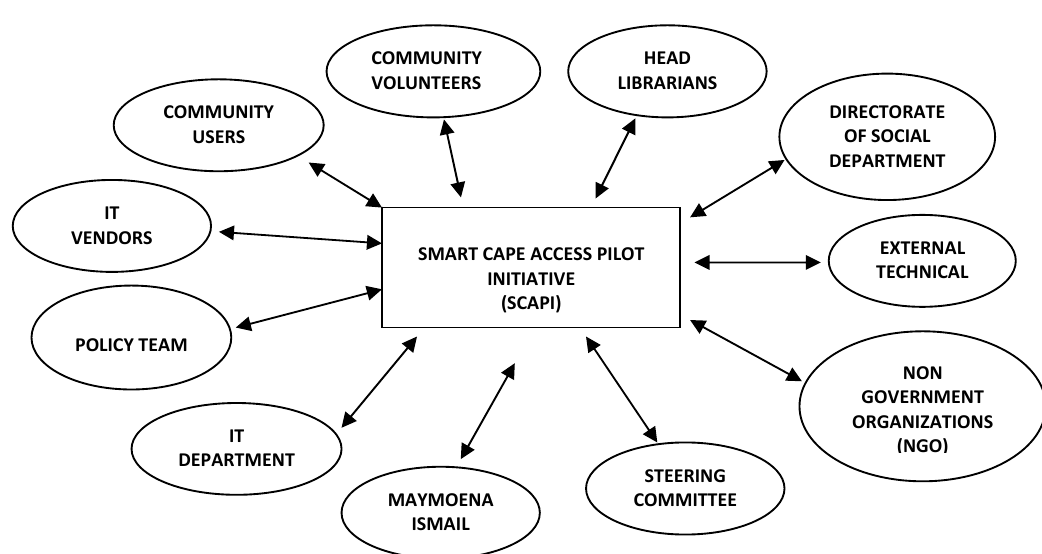
Figure 3: Smart Cape pilot project stakeholder